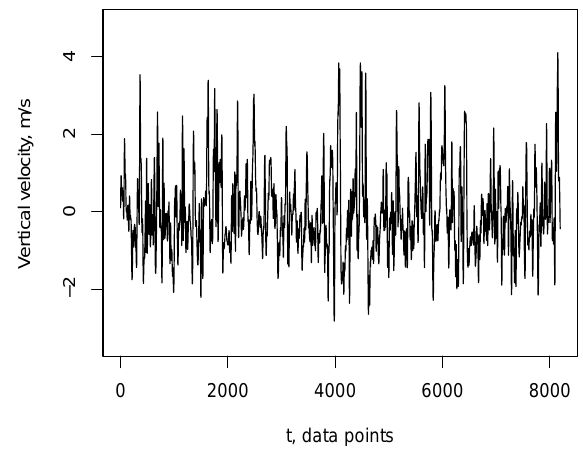
Fig. 1. Record of 20-Hz aircraft vertical velocity measurements over Lake Michigan. Figure from Gluhovsky (2011).